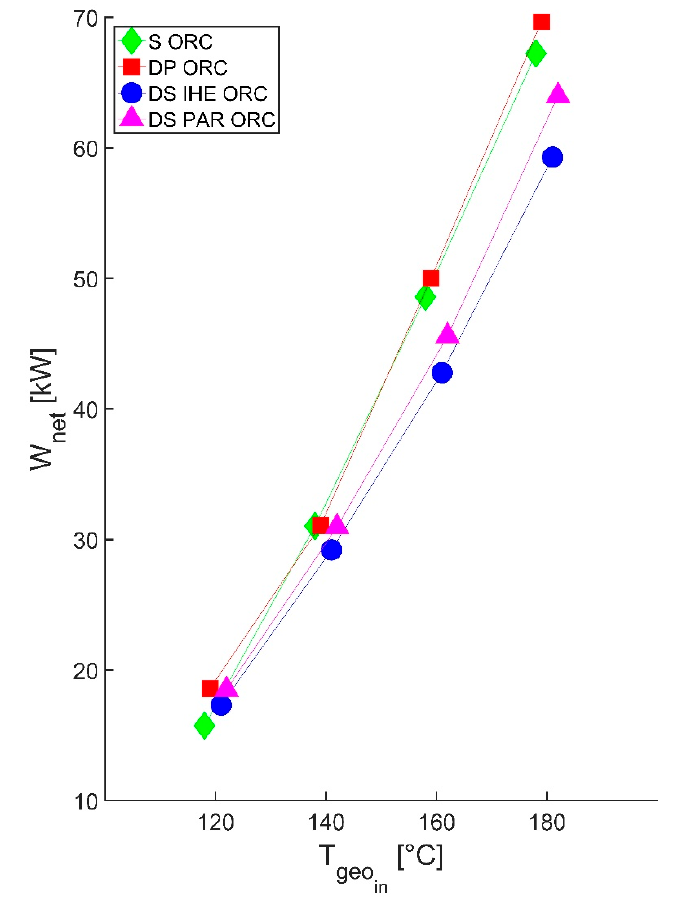
Figure 9. The best representatives of the individual ORC configurations that achieve the highest values of net power at characteristic temperatures of the geothermal fluid.